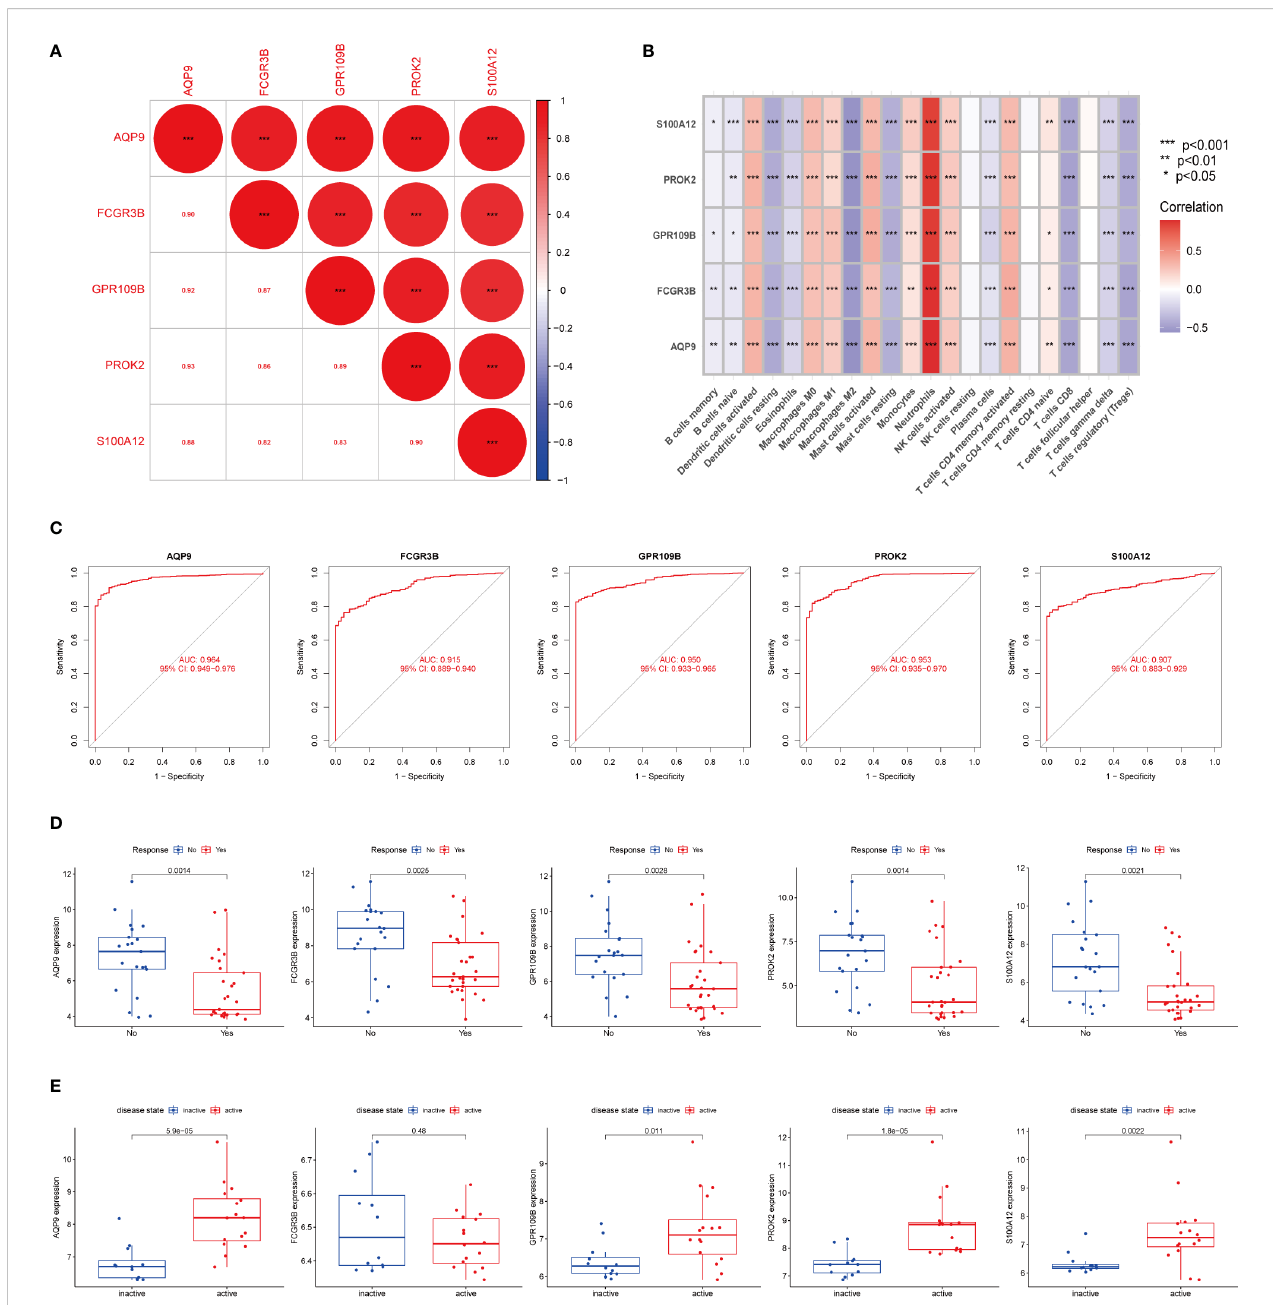
FIGURE 5 Identi fi cation of DEGs between subtypes (A) The correlation of fi ve DEGs. Red represented positive correlation. (B) Pearson correlation analysis revealed that immune cells had strong positive and negative correlations with DEGs. Red represented positive correlation, purple represented negative correlation. (C) The area under the ROC curve indicates the effectiveness of the fi ve DEGs in the diagnosis of UC. (D) Boxplot indicated that 5 DEGs could predict the effect of anti-TNF- a treatment in GSE92415 dataset. (E) Boxplot showed that in the GSE53306 cohort the expression of fi ve DEGs could distinguish between active UC and remission UC, except for FCGR3B. The upper and lower ends of the boxes represented the interquartile range of values. The lines in the boxes represented the median value. The asterisks represented the statistical p-value (*P < 0.05; **P < 0.01; ***P <